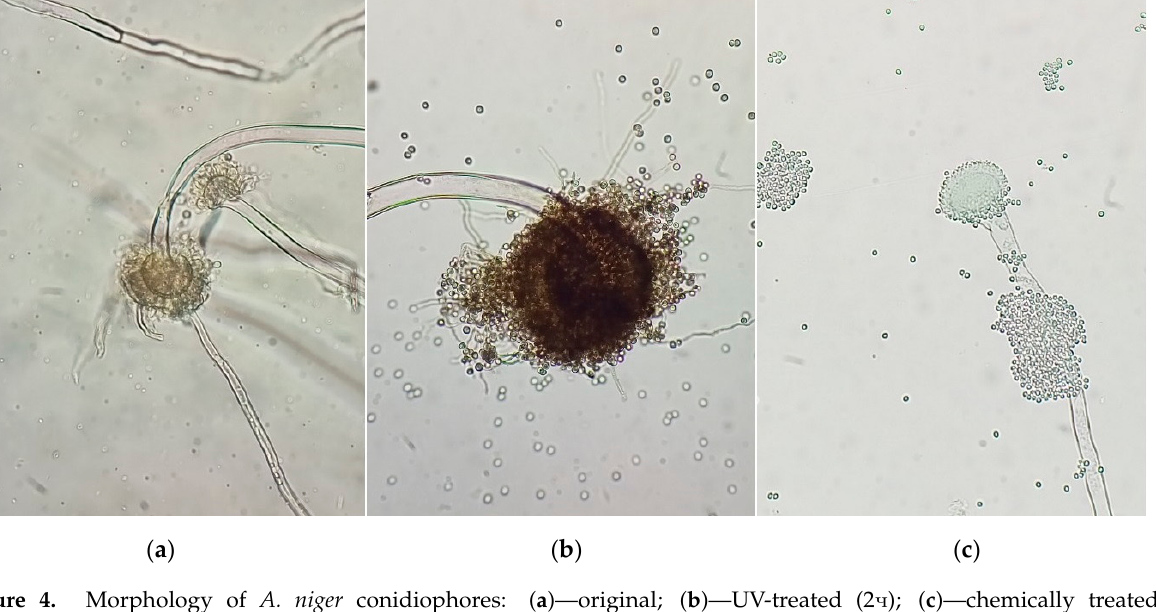
( f ) Figure 5. Qualitative assessment of the cellulolytic activity of the UV-treated A. niger strain: ( a ) all strains on one plate (left—mutants grown on potato agar (PA); right—grown on Mandels–Weber (M-W) medium; in the center control (C)—original strain; from top to bottom there are strains with different modes of exposure); ( b ) strain obtained by UV irradiation for 45 min; ( c ) strain obtained by UV irradiation for 1 h; ( d ) strain obtained by intermittent UV irradiation for 1 h, ( e )a strain ob- tained by UV irradiation for 2 h; ( f ) strain obtained by UV irradiation for 2 h with additional expo- sure (NaN3 + ItBr).